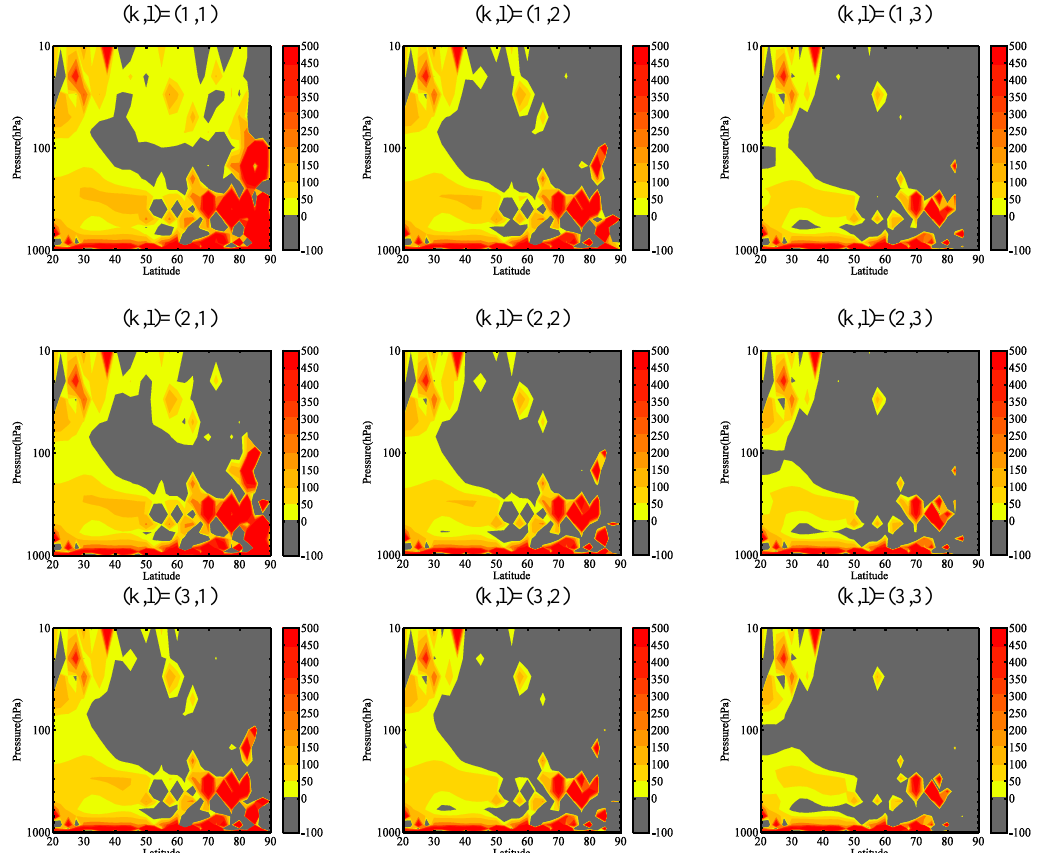
(y,z) ) of 50 winters (1961–2010) in the Northern hemisphere. Regions with k,l